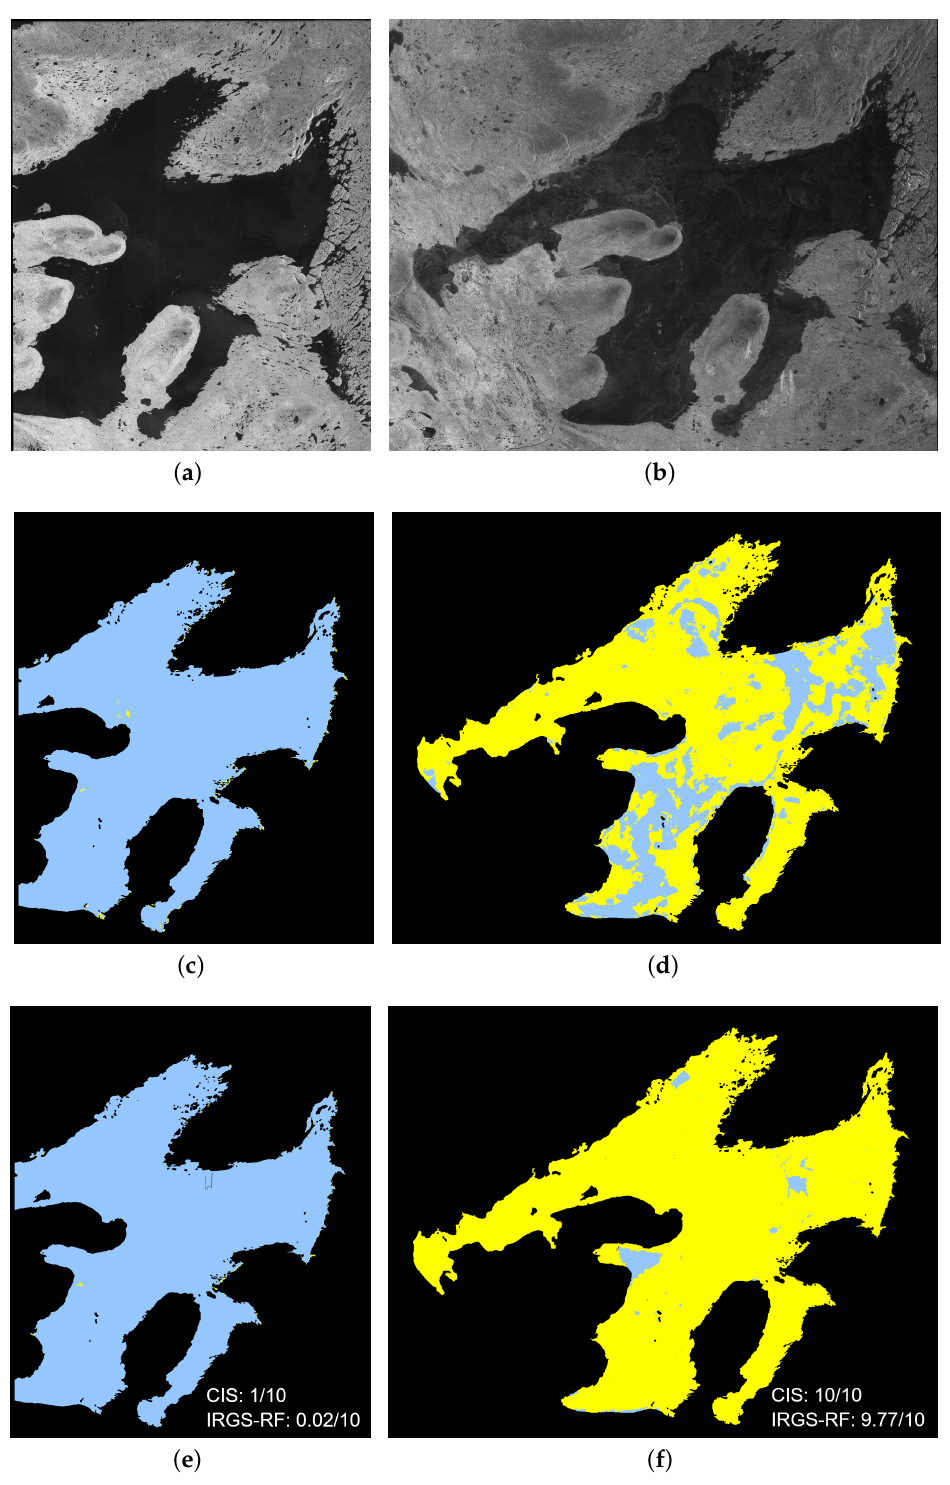
Figure 7. Ice-water classification of scenes where GBL is fully open water and fully ice covered. Ice is shown in yellow and water in blue. Left: classification results of 10 July 2014 with full open water. From top to bottom: ( a ) HH image, ( c ) RF pixel-wise classification with accuracy of 99.2%, and ( e ) IRGS-RF; IRGS segmentation labeled by RF with accuracy of 99.7%. Right: classification results of 18 May 2016, with full ice cover. From top to bottom: ( b ) HH image, ( d ) RF pixel-wise classification with accuracy of 72.3%, and ( f ) IRGS-RF; IRGS segmentation labeled by RF with accuracy of 95.5%. IRGS-RF and CIS ice cover fractions are shown in windows ( e , f ) for